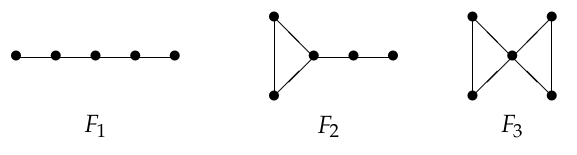
Figure 1. Graphs F 1 , F 2 , T 3 in Lemma